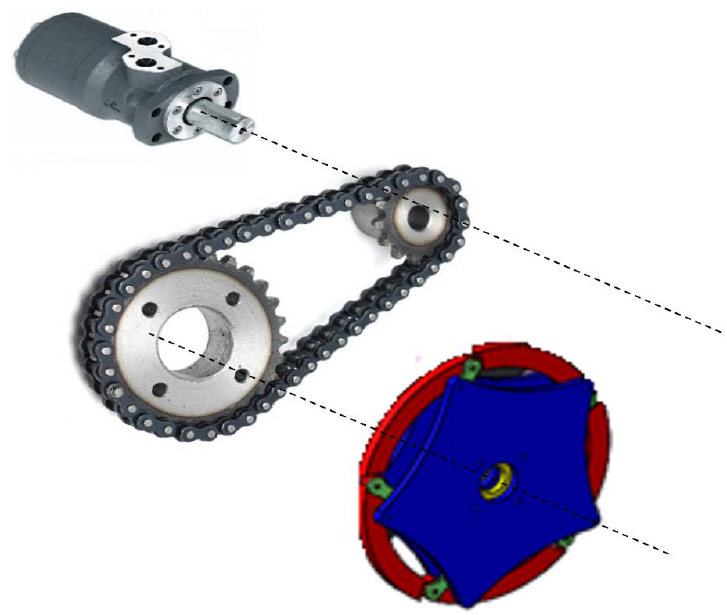
Figure 3. Wheel drive system of hydraulic motor with a gear-chain system.